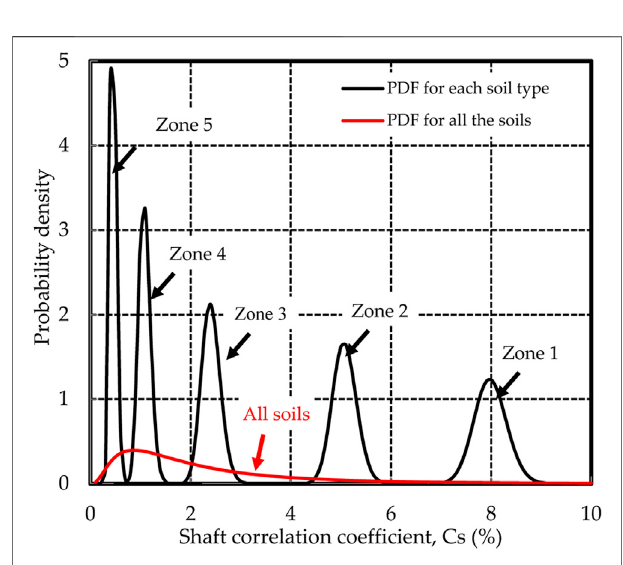
FIGURE 1 | Estimated PDFs of C s